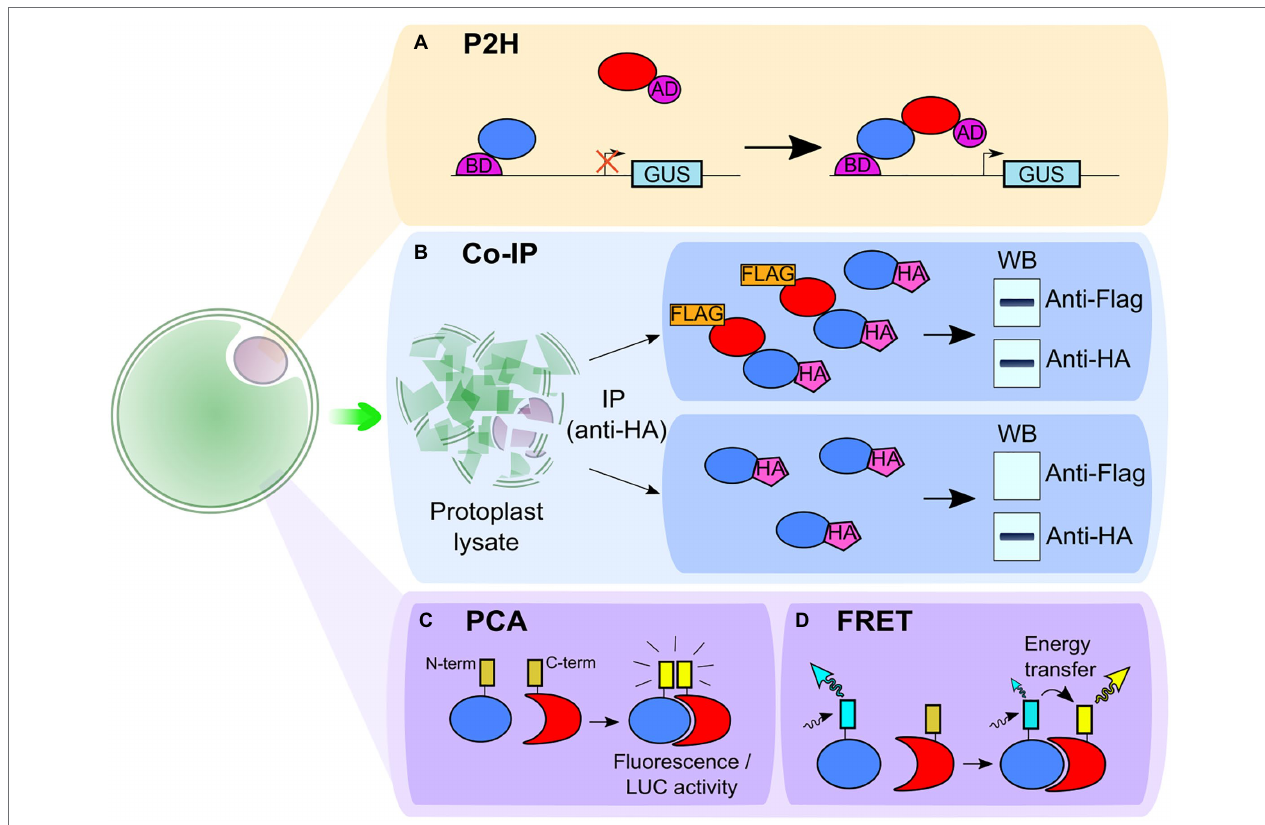
FIGURE 2 | Schematic representation of techniques associated with protoplasts to study protein–protein interaction. (A) In the protoplast two-hybrid (P2H) system, the protoplasts are transformed with the GAL4-UAS4:GUS reporter plasmid and the two putative interacting partners are fused to the binding domain (BD) and the activation domain (AD) of the transcriptional activator Gal4. An interaction between the partners leads to the transcription of the glucuronidase (GUS) gene and to a higher GUS activity. (B) In co-immunoprecipitation (co-IP), the two putative interacting partners are fused to two different epitopes [e.g., hemagglutinin (HA)-tag and FLAG-tag]. The proteins are then extracted from protoplast lysate with a co-IP using one of the two tags (here, the HA-tag). If the proteins are interacting, both HA- tagged and FLAG-tagged proteins are extracted which can be observed with a western blot (WB; upper box). If the proteins do not interact, only the HA-tag is detected in the western blot (bottom box). (C) In protein complementation assay (PCA), such as bimolecular fluorescence complementation (BiFC) or split luciferase complementation (SLC) assay, two fragments (the carboxy-terminal and the amino-terminal parts) of a reporter protein are fused to two putative interacting partners. In BiFC, the fragments come from a fluorescent protein and in SLC, from a luciferase enzyme. The interaction between partners leads to the association between the N- and C-ter fragments and restores fluorescence (for BiFC) or luciferase activity detected in the presence of luciferin (for SLC). (D) In Förster Resonance Energy Transfer (FRET), each of the two putative interacting partners is fused with one different fluorophore, either a donor or an acceptor. When the partners are interacting, the donor can transfer its energy of excitation to the acceptor, inducing a change in fluorescence intensity of the fluorophores and in the fluorescence lifetime of the